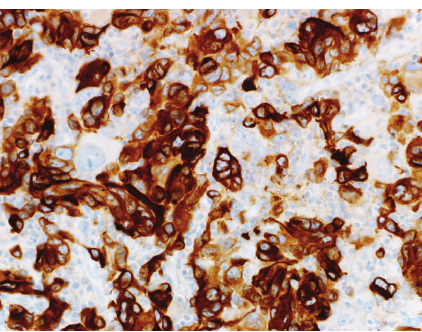
Figure 3: Melanin A stained 40x objective photomicrograph shows malignant cells stains strongly positive for melanin A.